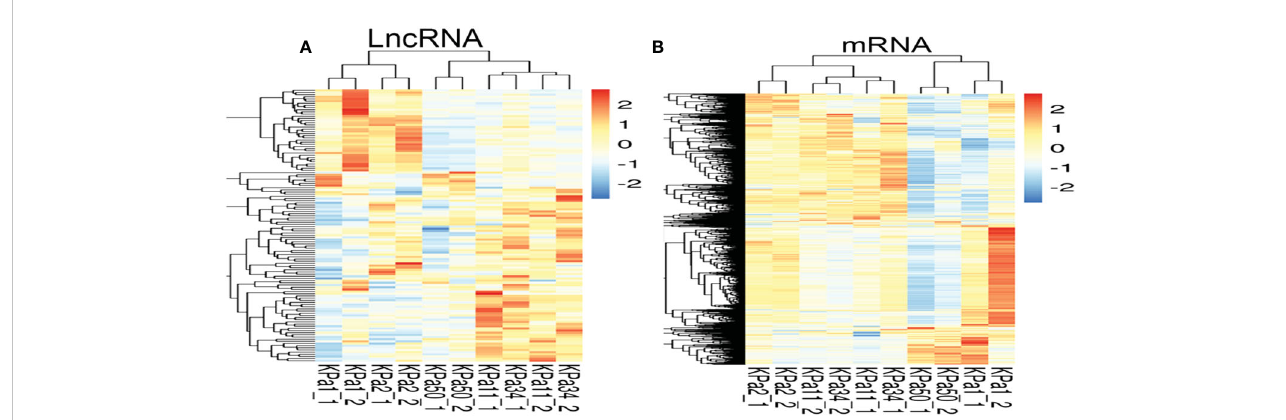
FIGURE 1 (A, B) Heat maps of mRNA and lncRNA(compare with 1 kpa). Each row represents one mRNA (A) or lncRNA (B) , and each column represents one different pressure value for the cell samples. Relative expression of mRNA or lncRNA is represented on a color scale. Red color indicates upregulation and blue indicates downregulation; 2, 0, -2, and 1.5, 0, -1.5 indicate fold changes in the corresponding